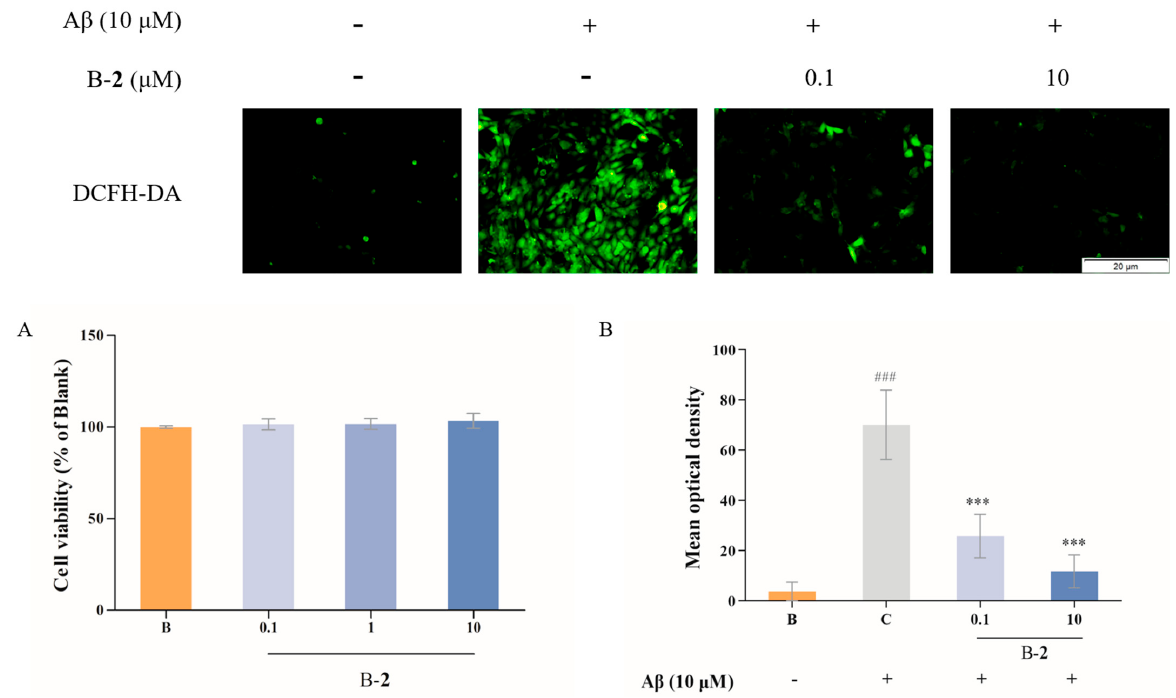
Figure 4. ( A ) The cell viability of compound 2 in HT − 22 cells. ( B ) ROS level of benzaldehydes 2 in HT − 22 cells. Data are expressed as the means ± SD ( n = 3). ### p < 0.001 vs. normal control group, *** p < 0.001 vs